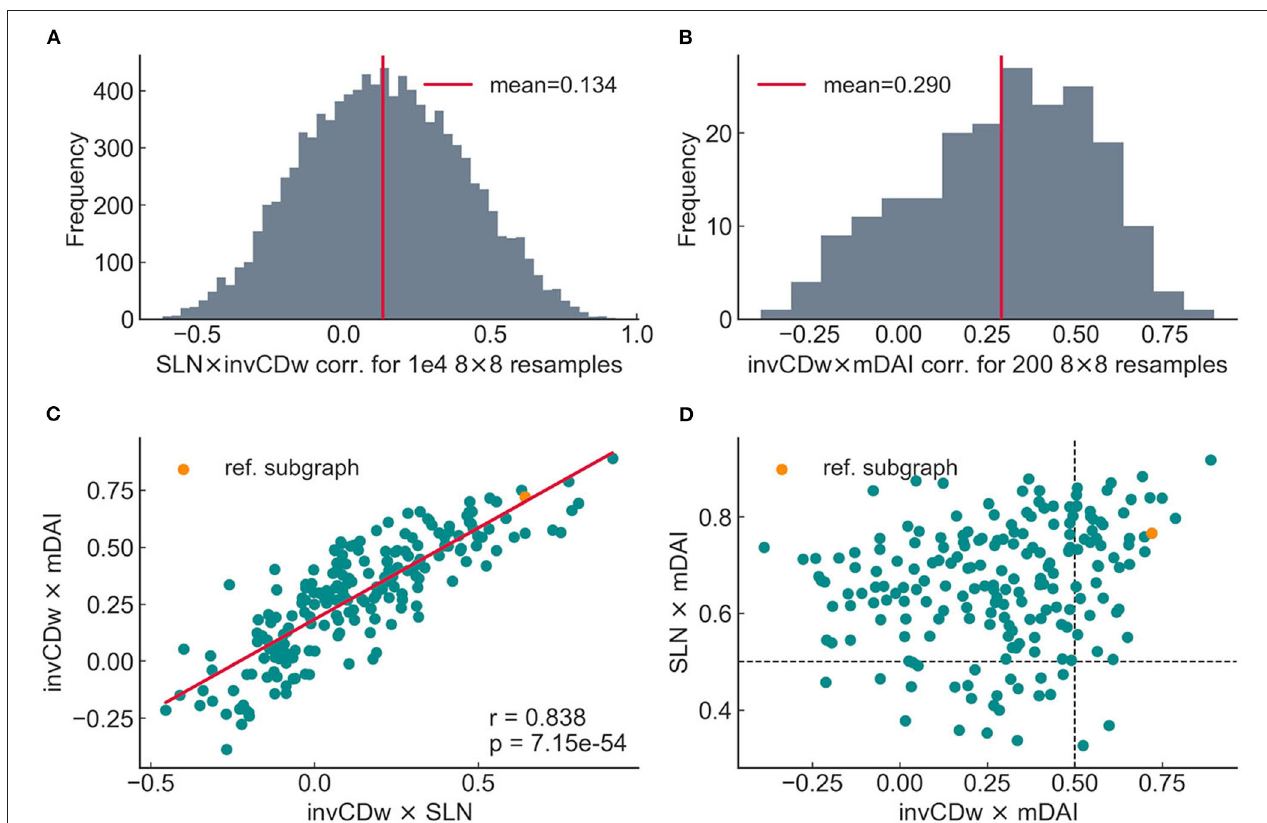
FIGURE 9 | Relationship between SLN, DAI, and invCDw in 8 × 8 subgraphs sampled randomly from the entire 29 × 29 graph. (A) Distribution of the SLN × invCDw correlation values in 10,000 unique 8 × 8 subgraphs. (B) Distribution of the invCDw × mDAI correlation values in 200 unique 8 × 8 subgraphs. The relatively small number of samples is due to the simulation of the dynamics (and therefore the DAI) being very expensive computationally. (C) A strong correlation was found between the invCDw × SLN and the invCDw × mDAI correlations in the 200 random samples. (D) In general, invCDw × mDAI and the SLN × mDAI did not correlate in the 200 random samples. Strong correlation appeared only in a relatively small number of higher values (upper right quadrant demarcated by the dashed lines). The orange dot indicates the reference 8 × 8 subgraph studied with higher detail. The notations are the same as in the previous